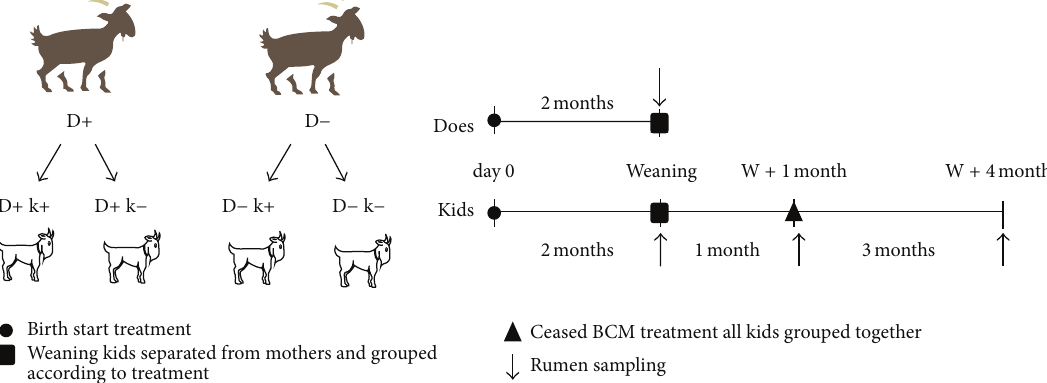
Figure 1: Experimental design and sampling schedule. W = weaning; D+ k+ = treated kids from treated does; D+ k − = untreated kids from treated does; D − k+ = treated kids from untreated does; D − k − = untreated kids from untreated